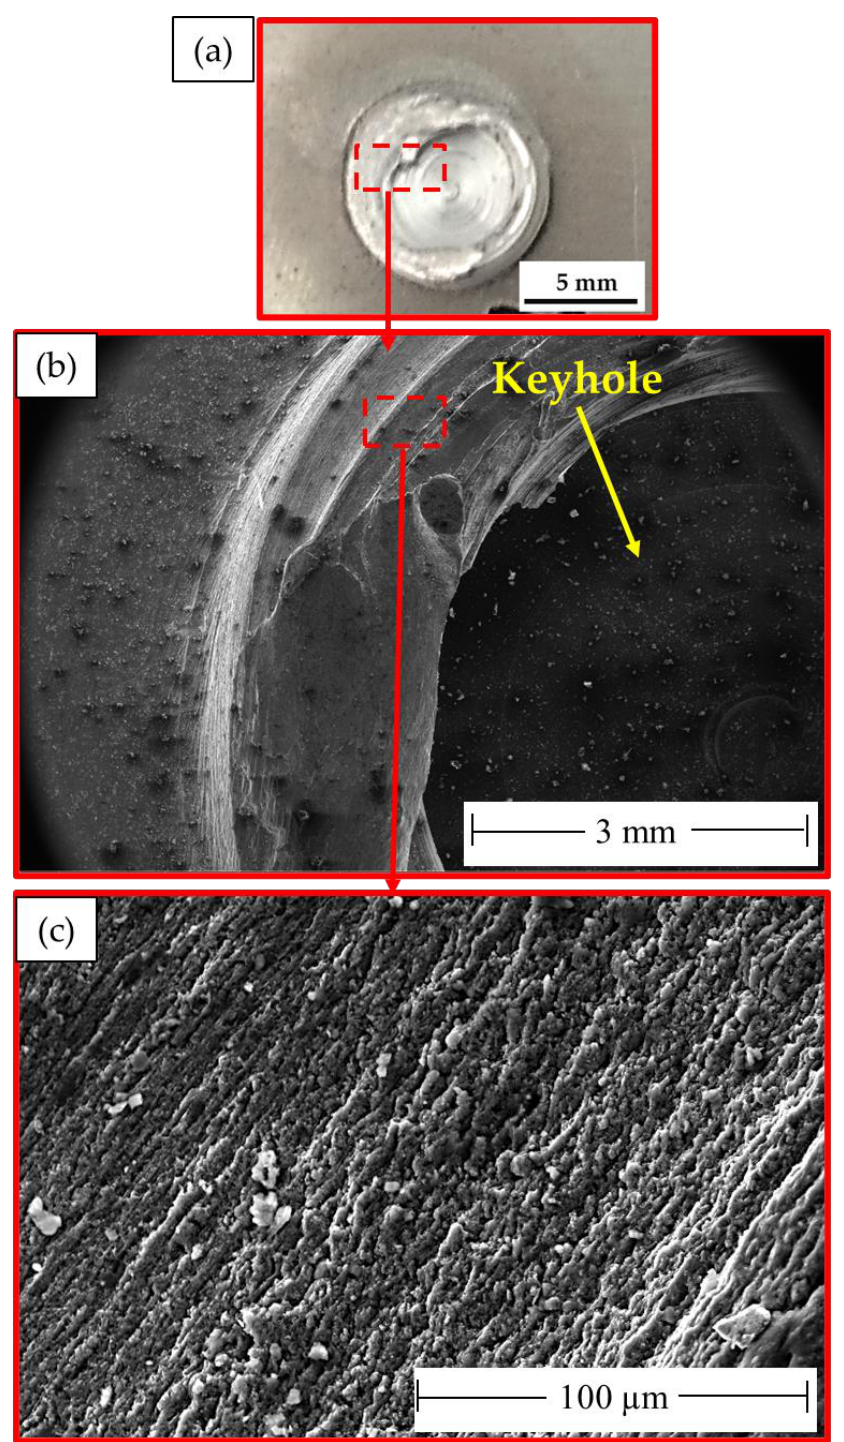
Figure 15. ( a ) Photograph of the top surface of the lower sheet of the joint FSSWed at 500 rpm and 3 s after tension test and ( b , c ) different magnifications of SEM fracture surfaces of the failed joint. Note: dotted red lines enclosed area indicating where the micrographs were taken.